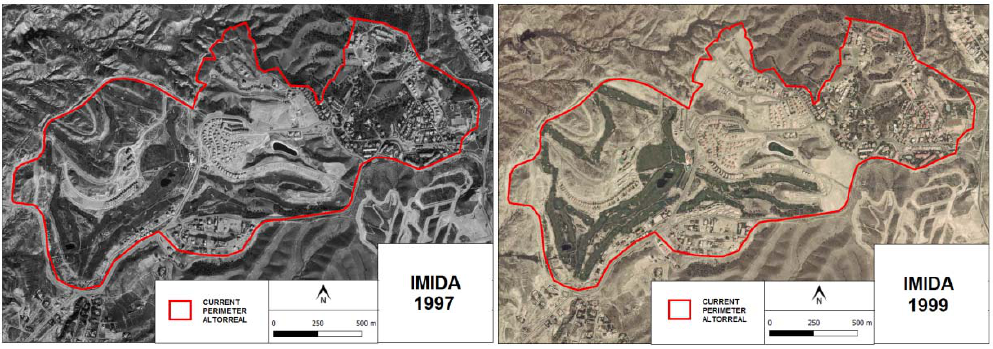
Figure 5. The starting point of the Altorreal Golf Resort.